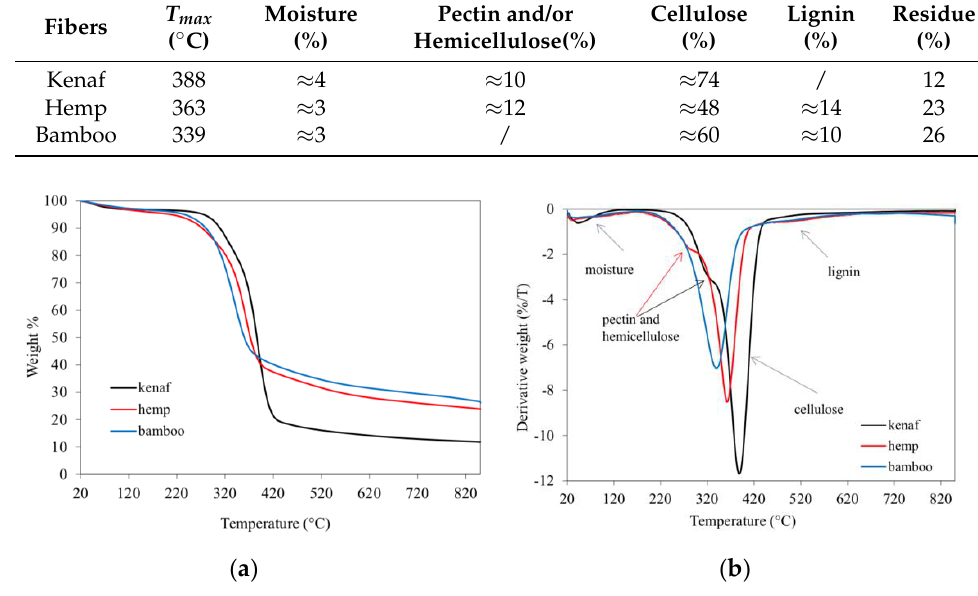
Figure 2. TGA ( a ) and dTGA ( b ) profiles of the fibers.